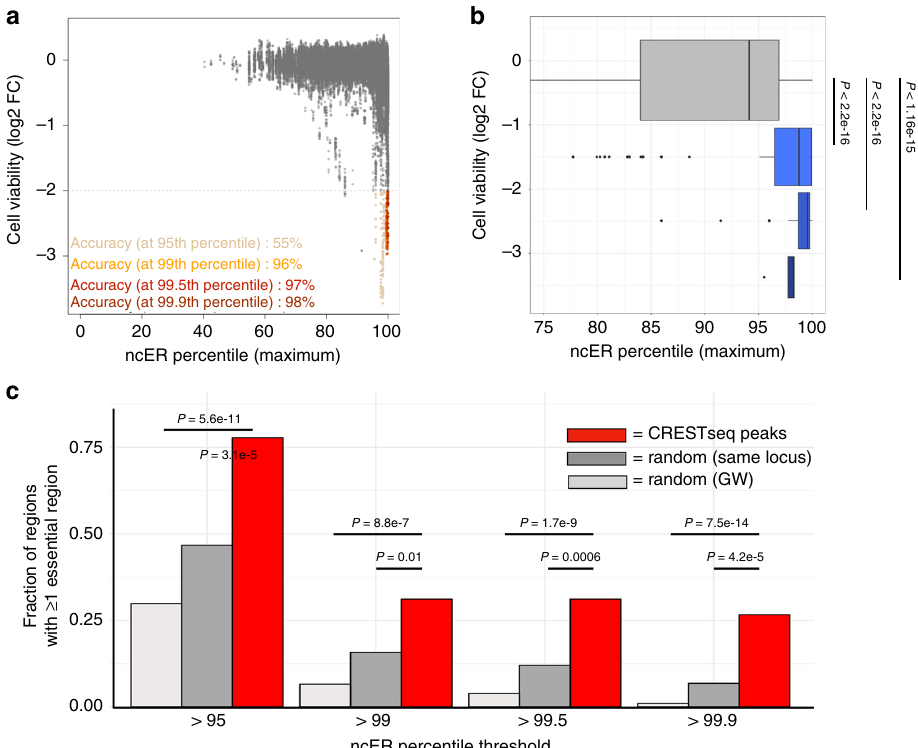
Fig. 2 Comparison of experimental functional assays with in silico ncER predictions. a CRISPRi effect on cell viability (75,622 sgRNA probes pairs) from Fulco et al. 32 and the corresponding maximum ncER score across the GATA1 and MYC loci. Accuracy at four ncER thresholds is shown in yellow, orange, red and dark-red respectively for the 95th, 99th, 99.5th and 99.9th percentiles. b Distribution of maximum ncER at different bins of cell viability (0 to less than − 3 log2 fold change). The boxplot ’ s central line represents the median, the bounds represent the 25th and 75th percentile, and the whiskers extend up to 1.5 the interquatile range from the respective bounds. p Values were computed with independent two-group Mann – Whitney unpaired test. c Fraction of regions with at least one high ncER score, as de fi ned by four different ncER percentile thresholds. CRESTseq peaks are shown in red ( N = 45), random matched sized in silico regions extracted from the same locus ( “ random same locus, N = 4500) in dark gray and random matched sized in silico regions extracted genome-wide ( “ random GW ” , N = 4500), in light gray. p Values were computed with Fisher's exact test. FC fold change, CRESTseq cis - regulatory elements by tiling-deletion and sequencing, GW genome-wide, CRISPRi clustered regularly interspaced short palindromic repeats